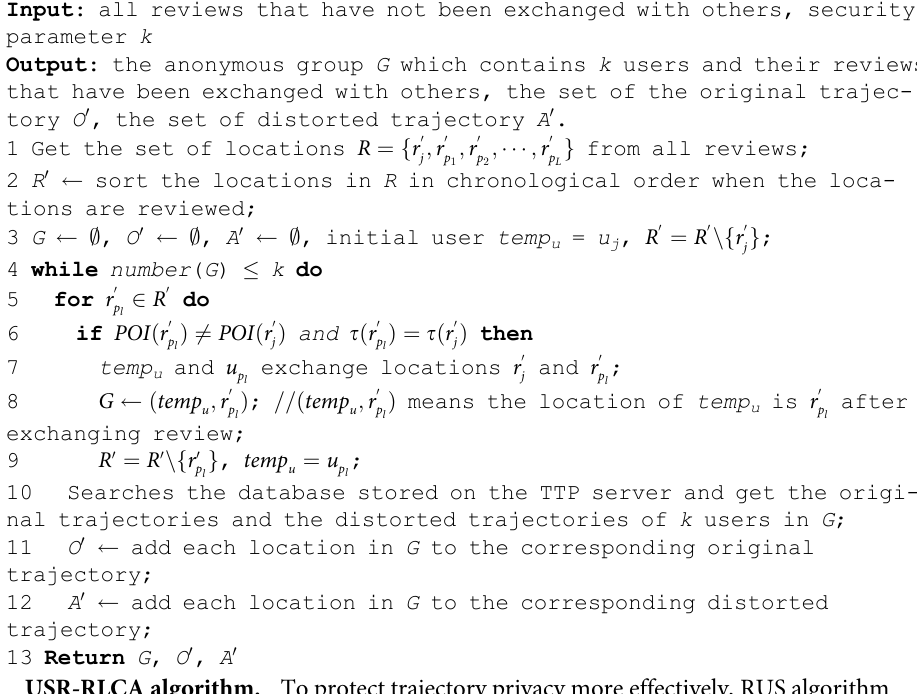
Algorithm 1 : Random-User Selection